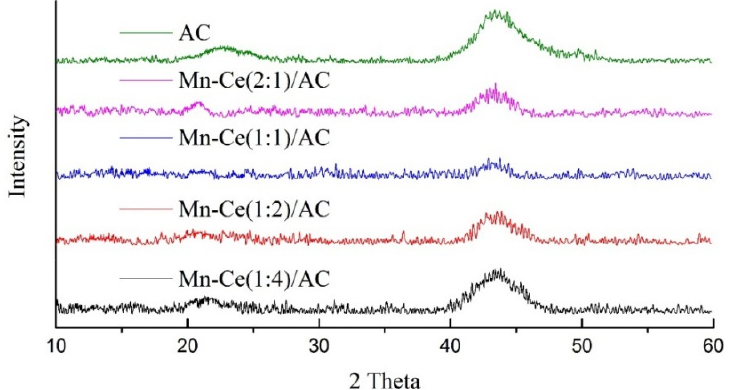
Figure 5. X-ray diffraction (XRD) analysis of the selected catalysts.